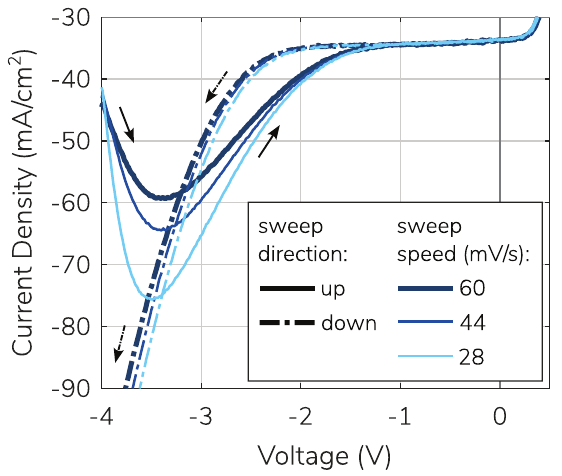
Fig. 1. Hysteresis in reverse IV measurements. Up-sweeps with increasing voltage (solid lines) lead to different results than down- sweeps with decreasing voltage (dashed-dotted lines). The reverse IV curve is also in fl uenced by the speed of the voltage sweeps